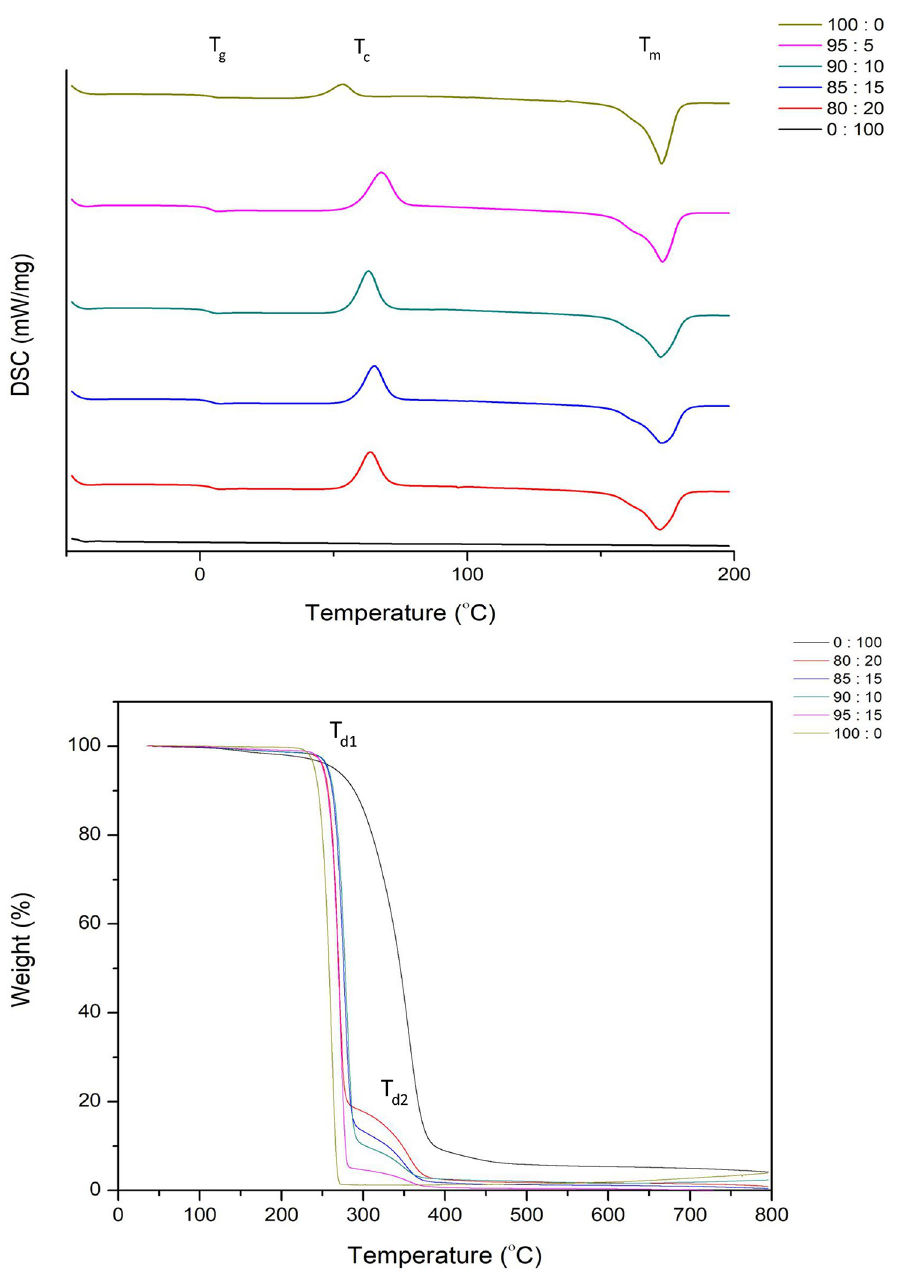
Fig 10. DSC thermograms (A) of PHB/esterified PALF-MCC laurate biocomposite films and TGA thermograms (B) of PHB/esterified PALF-MCC laurate biocomposite